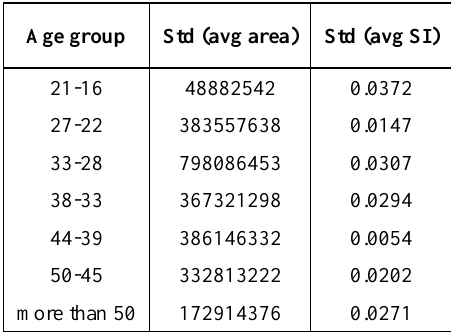
Table 12. Comparison of the effect of weekdays on users' activity space with different age group.